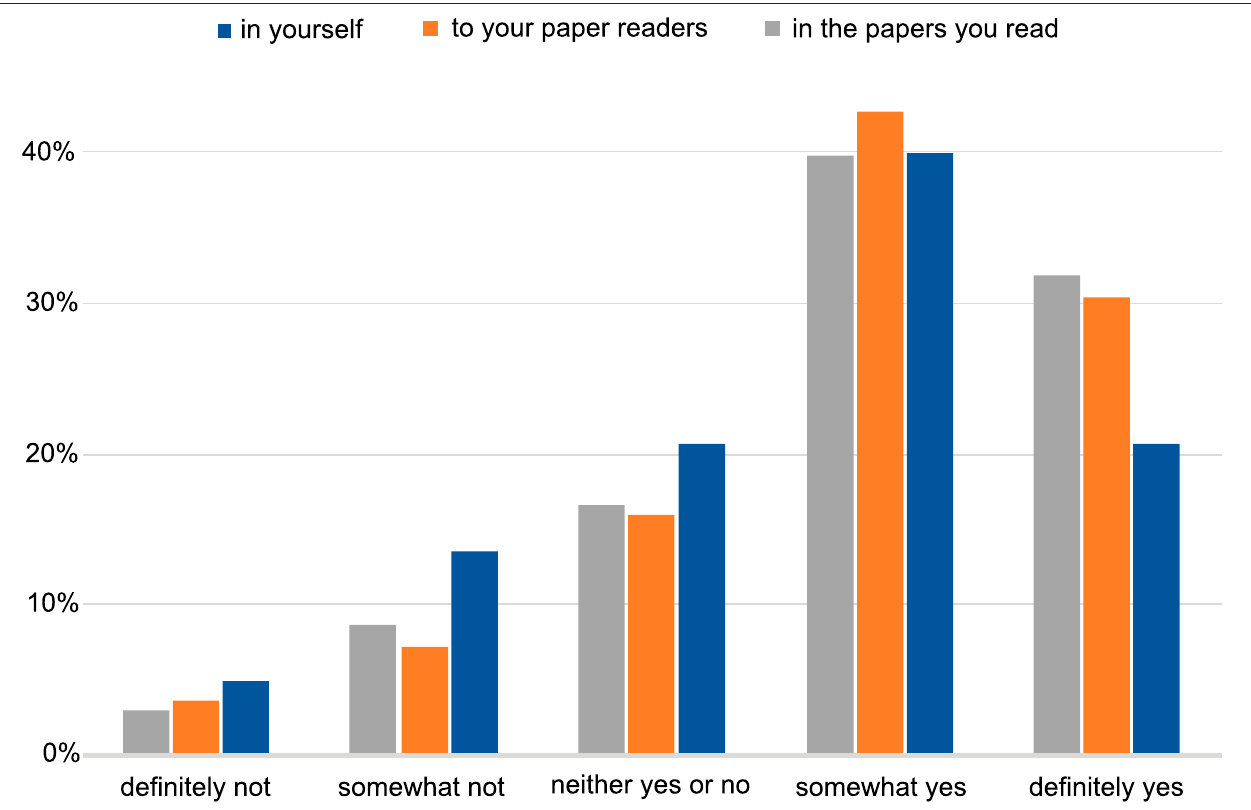
FIGURE 4 | The level of perception of bene fi t to having the ability to publish papers with interactive fi gures. The bene fi t to the author, to the readers of the author ’ s papers and to the papers the author reads. Answers include the responses from both NBI and eLIFE surveys for question 11.